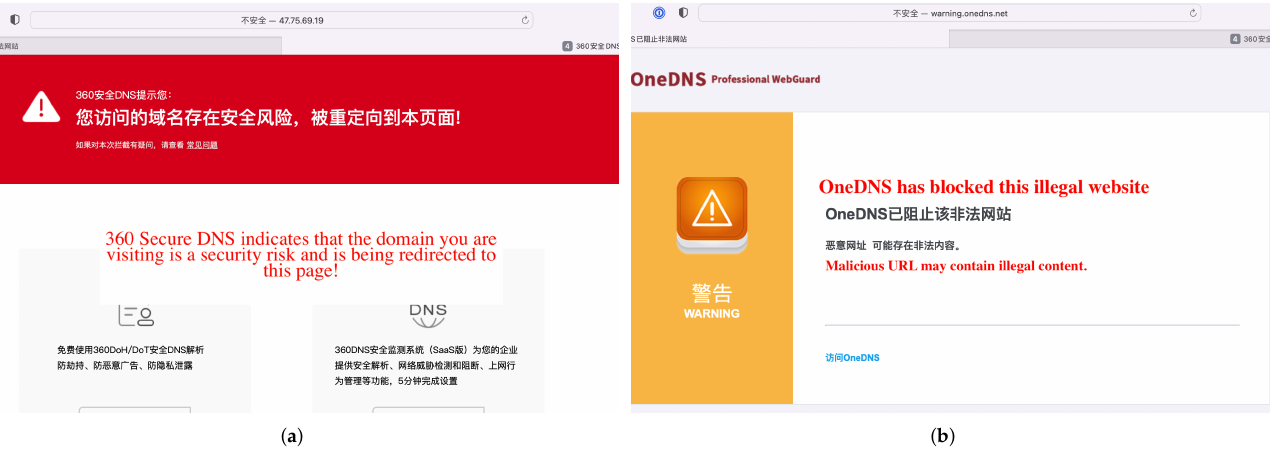
Figure 8. Recursive DNS servers use DNS redirect to handle abusive domains. ( a ) DNSpai. ( b )